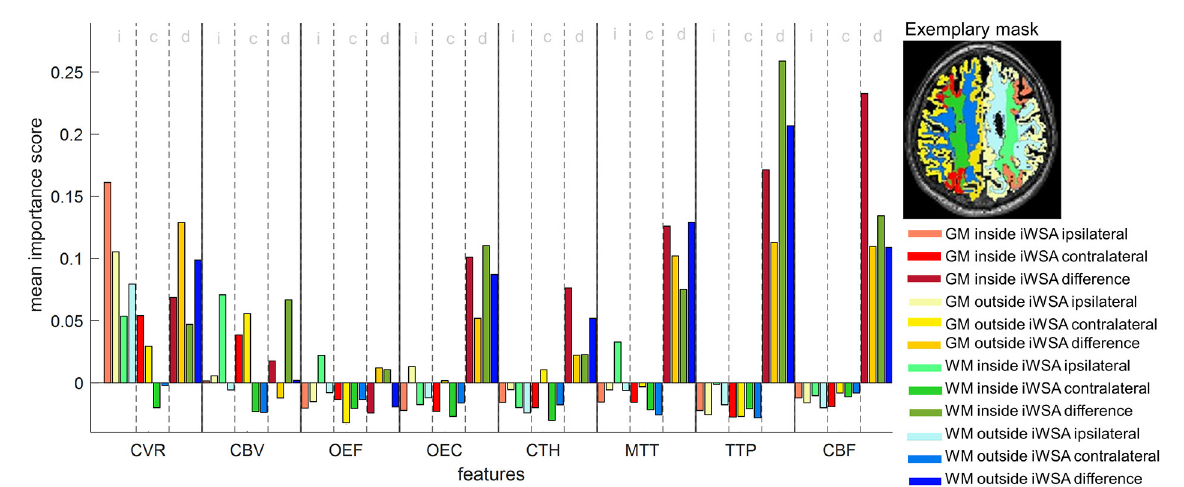
FIGURE2 Feature importance scores of a random forest classifier trained with 96 features. Scores were averaged 1,000 times. Features were extracted from eight MRI parameter maps [cerebrovascular reactivity (CVR), cerebral blood volume (CBV), oxygen extraction fraction (OEF), oxygen extraction capacity (OEC), capillary transit time heterogeneity (CTH), mean transit time (MTT), time to peak (TTP) and cerebral blood flow (CBF)], with each sampled from 12 different VOIs that are shown as color overlays in the inset on the right. For each parameter, the first, second and third group of four bars refer to ipsilateral (i) and contralateral (c) mean values, and interhemispheric differences (d) between mean values, respectively. For each group, the color scheme is similar for GM inside of iWSAs (red), GM outside of iWSAs (yellow), WM inside of iWSAs (green) and WM outside of iWSAs (blue). The color intensity increases from group one to